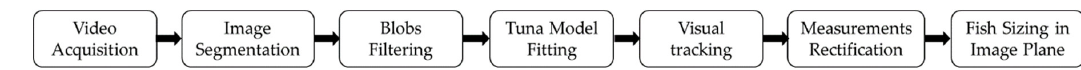
Figure 6. Sequence of video processing algorithms involved in the process of fish sizing.